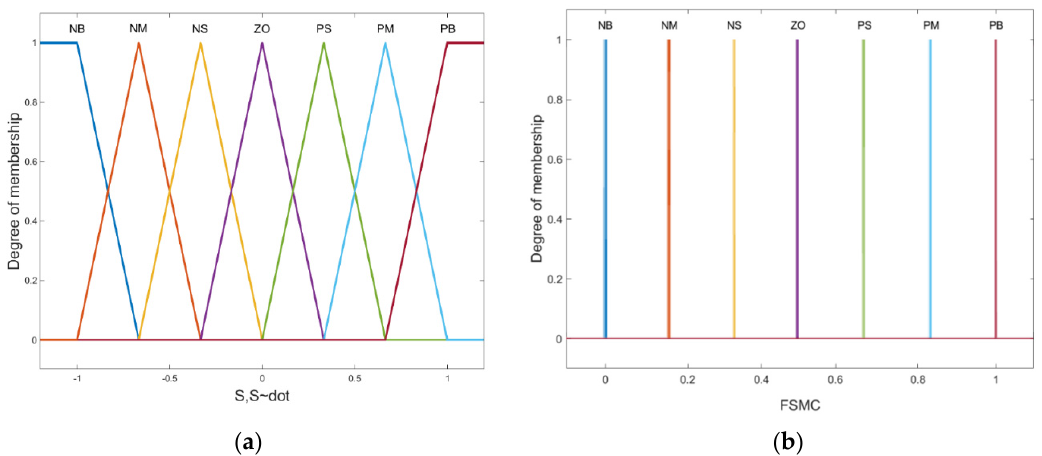
(cid:16) (cid:17) . s i , s i ;